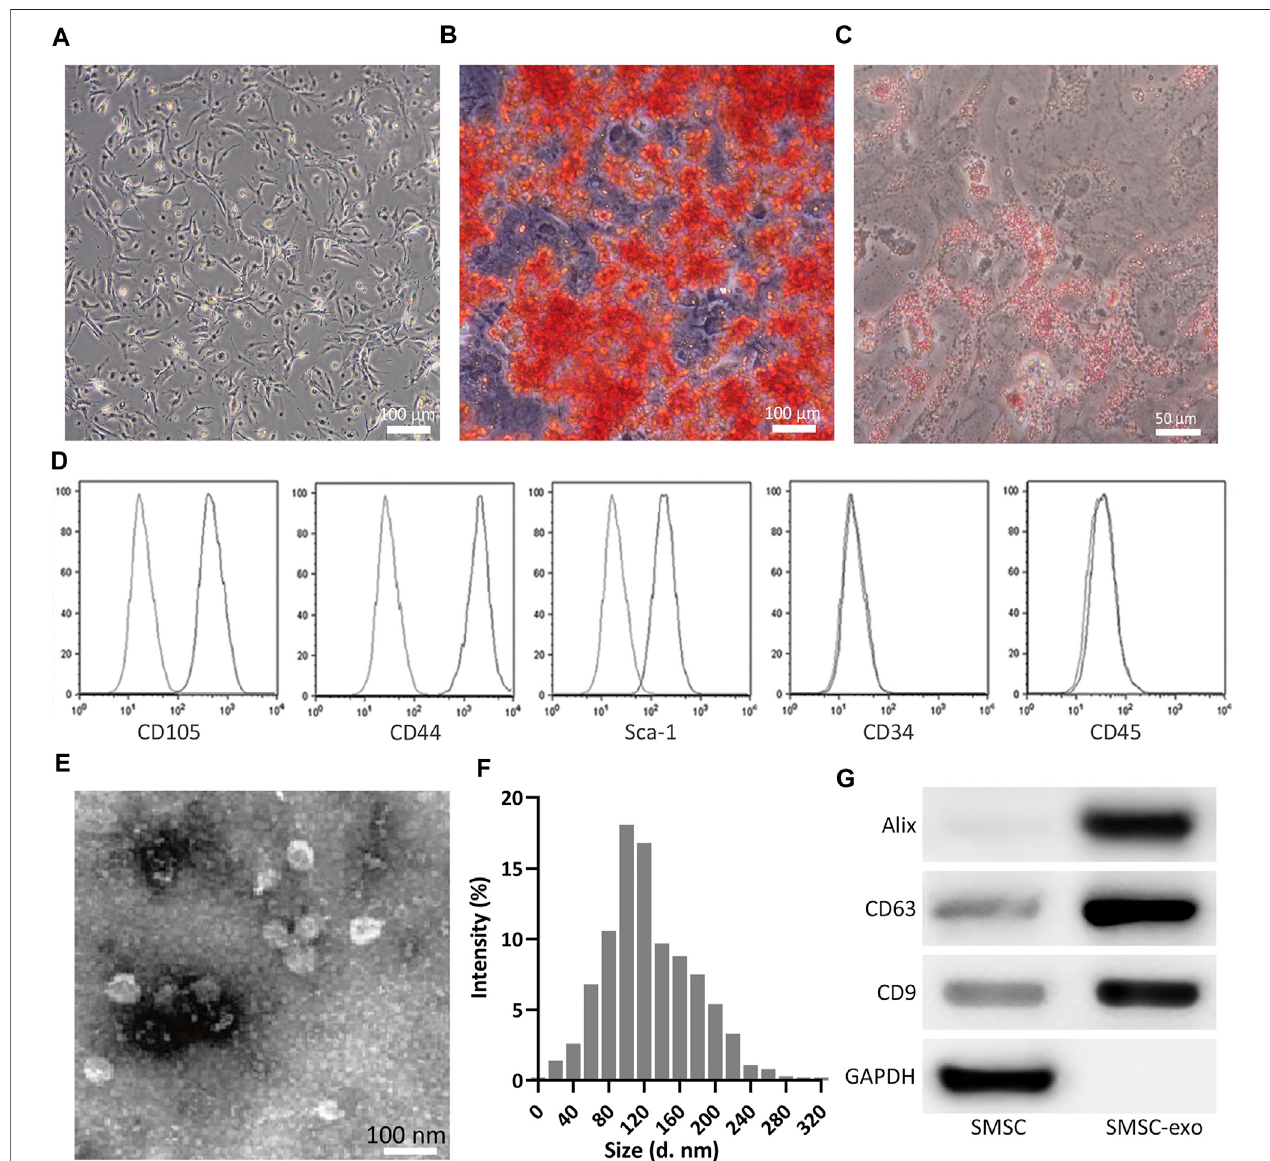
FIGURE2| IsolationofSMSCsandSMSC-derivedexosomes(SMSC-Exos). (A) ObservationofSMSCsmorphologyatpassage3. (B) After14 daysofosteogenic differentiation, matrix mineralization of SMSCs was stained with Alizarin Red S. (C) after 14 days of adipogenesis induction, SMSCs were stained with Oil Red O. (D) Fluorescence Activated Cell Sorting was performed on SMSCs for CD105, CD44, Sca-1, CD34, and CD45 at passage 3. (E) Identi fi cation of exosomes by TEM. (F) Nanoparticle Tracking Analysis of the isolated exosome. (G) Detection of CD9, CD63, and Alix expression by Western blot analysis between SMSCs and SMSC- derived exosomes